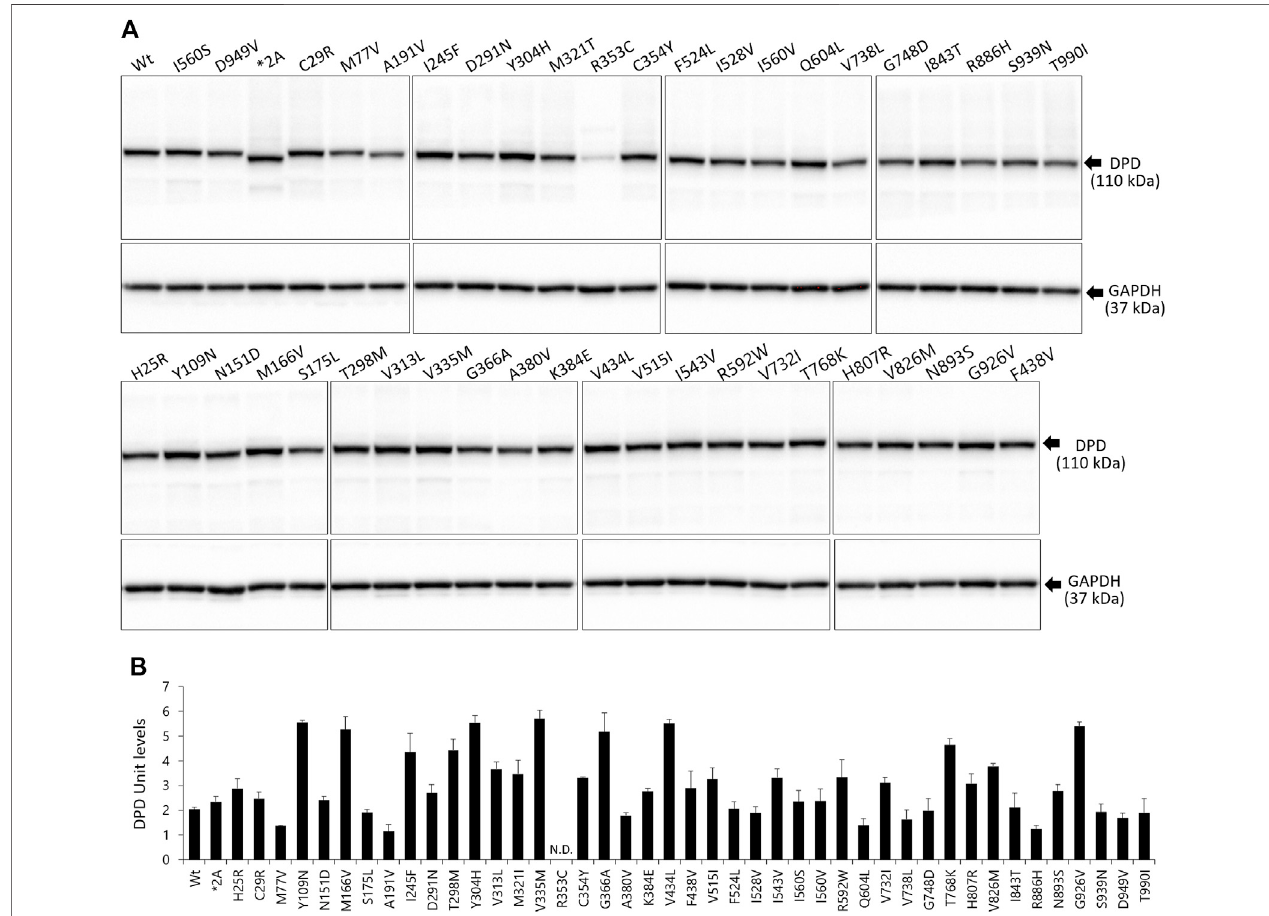
FIGURE2 | Expressionlevels ofwild-type and variant DPD proteins. (A) DPD protein levels weredeterminedby immunoblottinganalysisfollowing SDS-PAGE. (B) DPD units of proteins expressed in 293FT cells. Each bar represents the mean ± standard deviation of three independent assays.